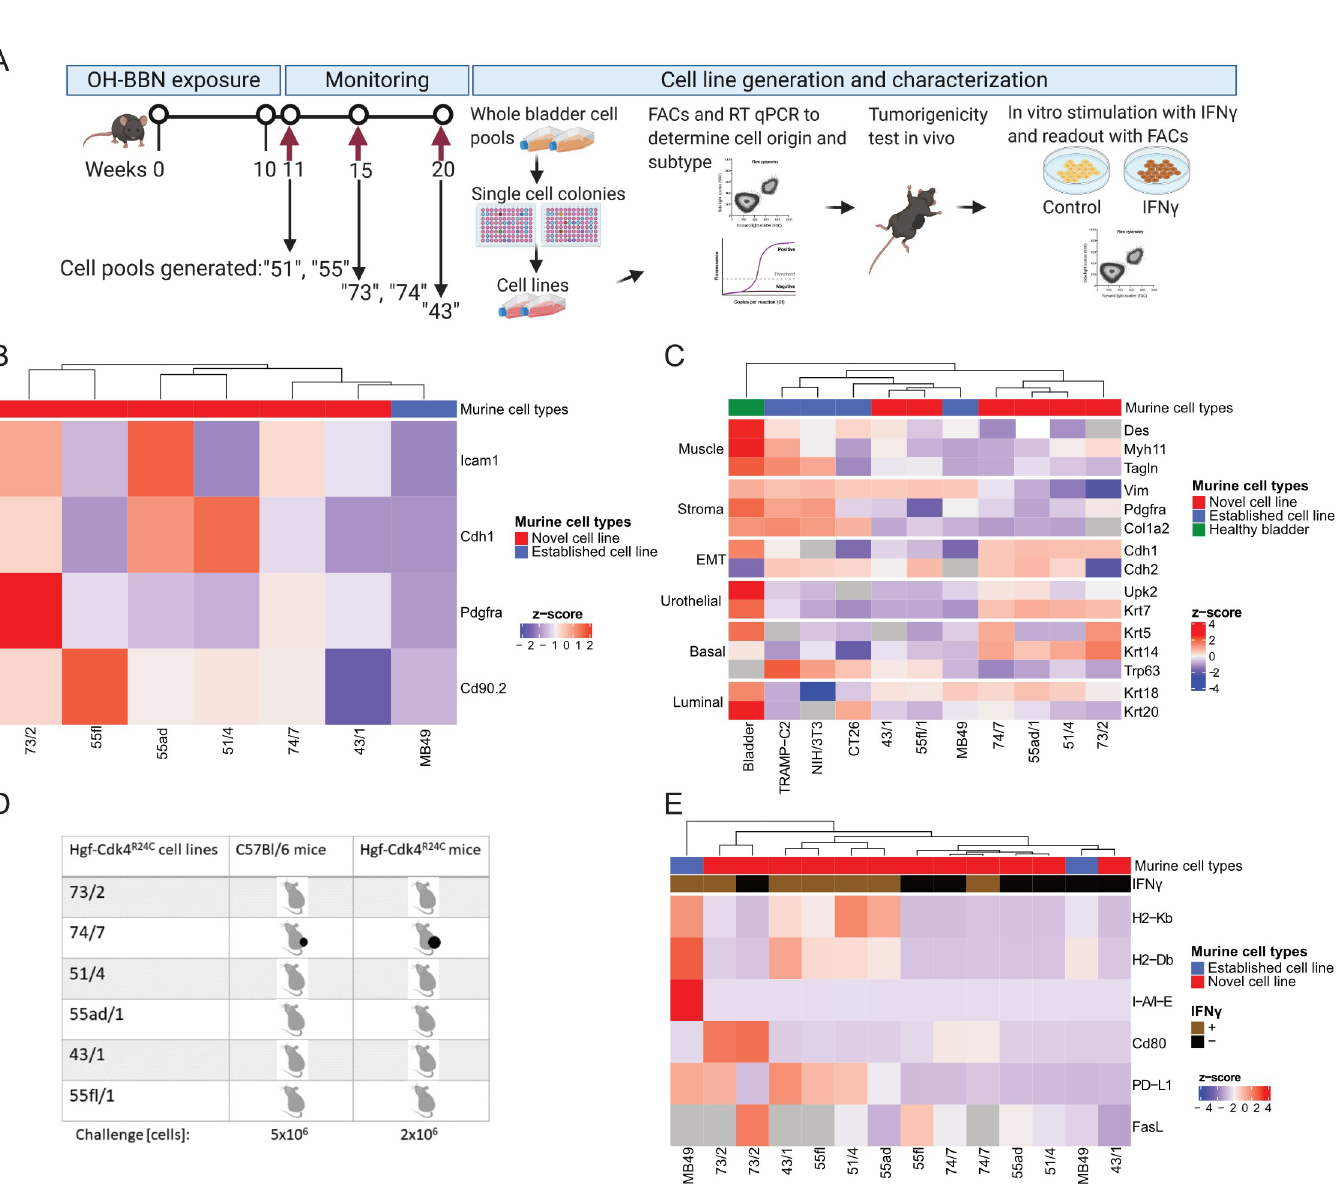
Fig 2. Development and characterization of the cell cultures developed from bladder tumors in Hgf-Cdk4 R24C mice. (A) For cell line generation, female Hgf- Cdk4 R24C mice were exposed for 10–11 weeks to OH-BBN in drinking water. After OH-BBN discontinuation, mice were monitored for 1, 5 or 10 weeks and sacrificed. Six single cell colonies were randomly selected and characterized by (B) expression of surface markers by flow cytometry or (C) qRT-PCR to determine the cell origin and molecular profile of the cells in comparison to established cell lines or healthy bladder urothelium. (D) Only the 74/7 cell line formed tumors after subcutaneous inoculation to C57BL/6 or Hgf-Cdk4 R24C mice in doses of 5 or 2x10 6 cells, respectively. The new cell lines and MB49 cells were cultured with or without IFN γ (10 ng/ml) for 24h and (E) the expression of cell surface immune recognition markers was analyzed by flow cytometry (normalized to unstained control cells).